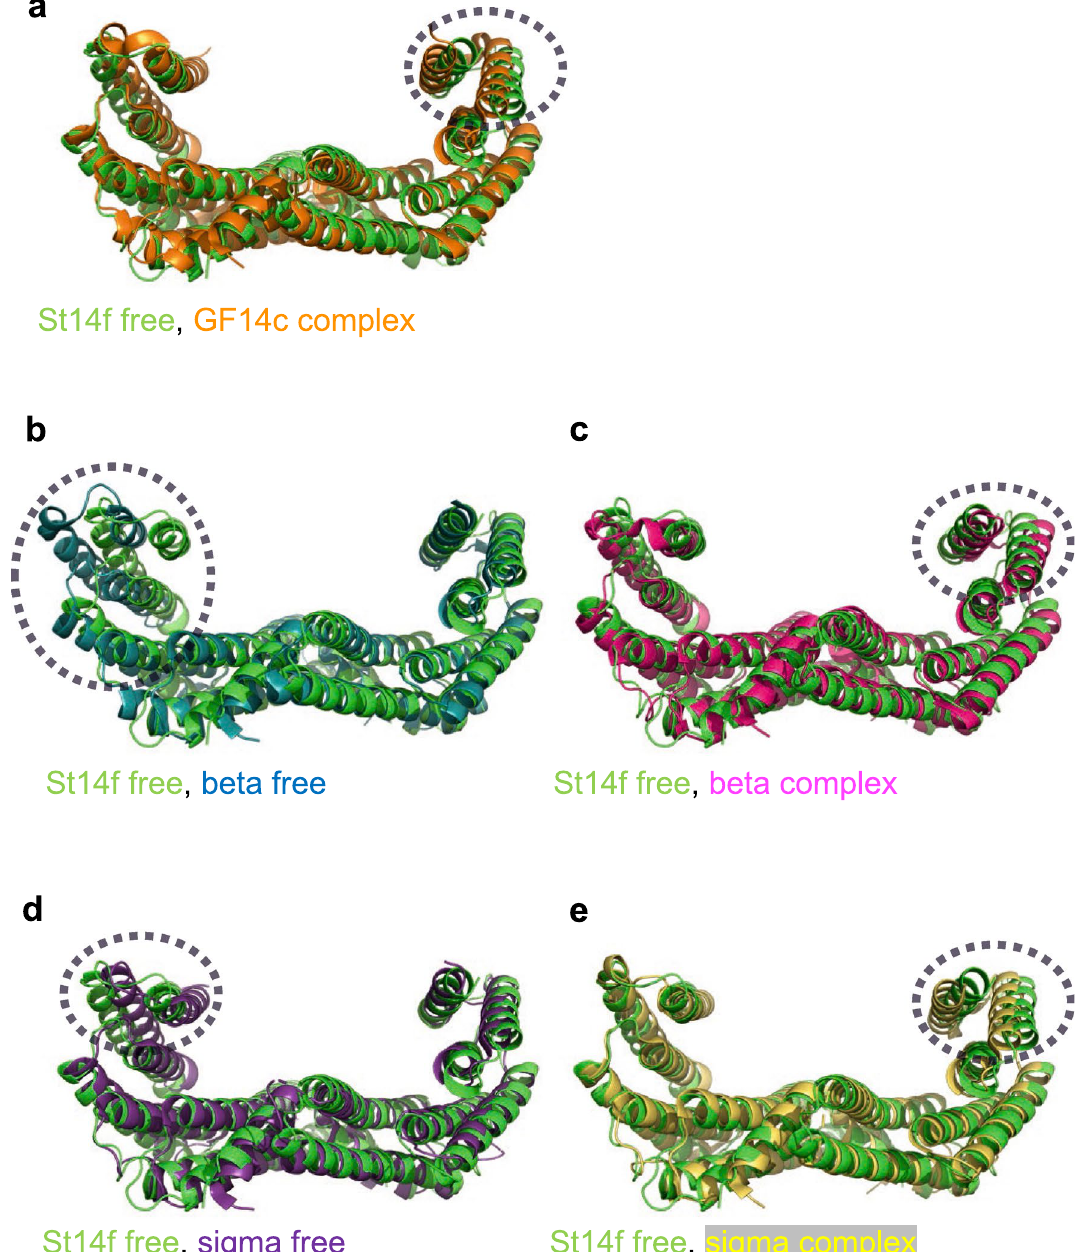
Figure 2. Superposition between the St14f free form (chain AA, green) and other 14-3-3 protein dimers. ( a ) Rice GF14c complex form (orange) reported in PDB ID 3axy, ( b ) human 14-3-3 beta free form (blue)